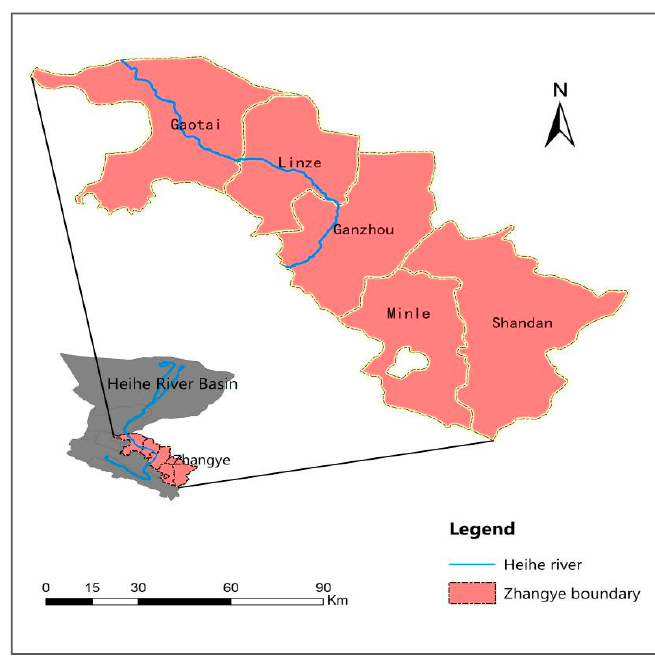
Figure 1. Schematic diagram of the study